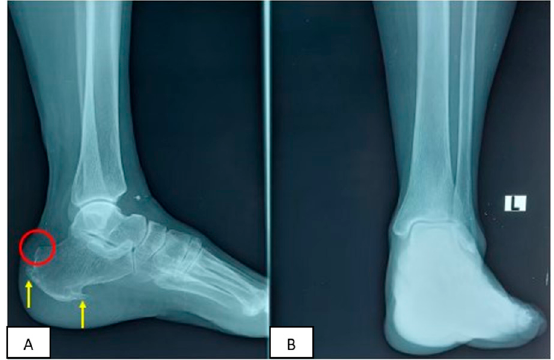
Figure 2. Preoperative X-ray of left ankle: ( A ) lateral view; ( B ) anteroposterior view. Note the observed prominent Haglund’s deformity (red circle) with dorsal and plantar osteophyte formation on the calcaneus bone (arrow).